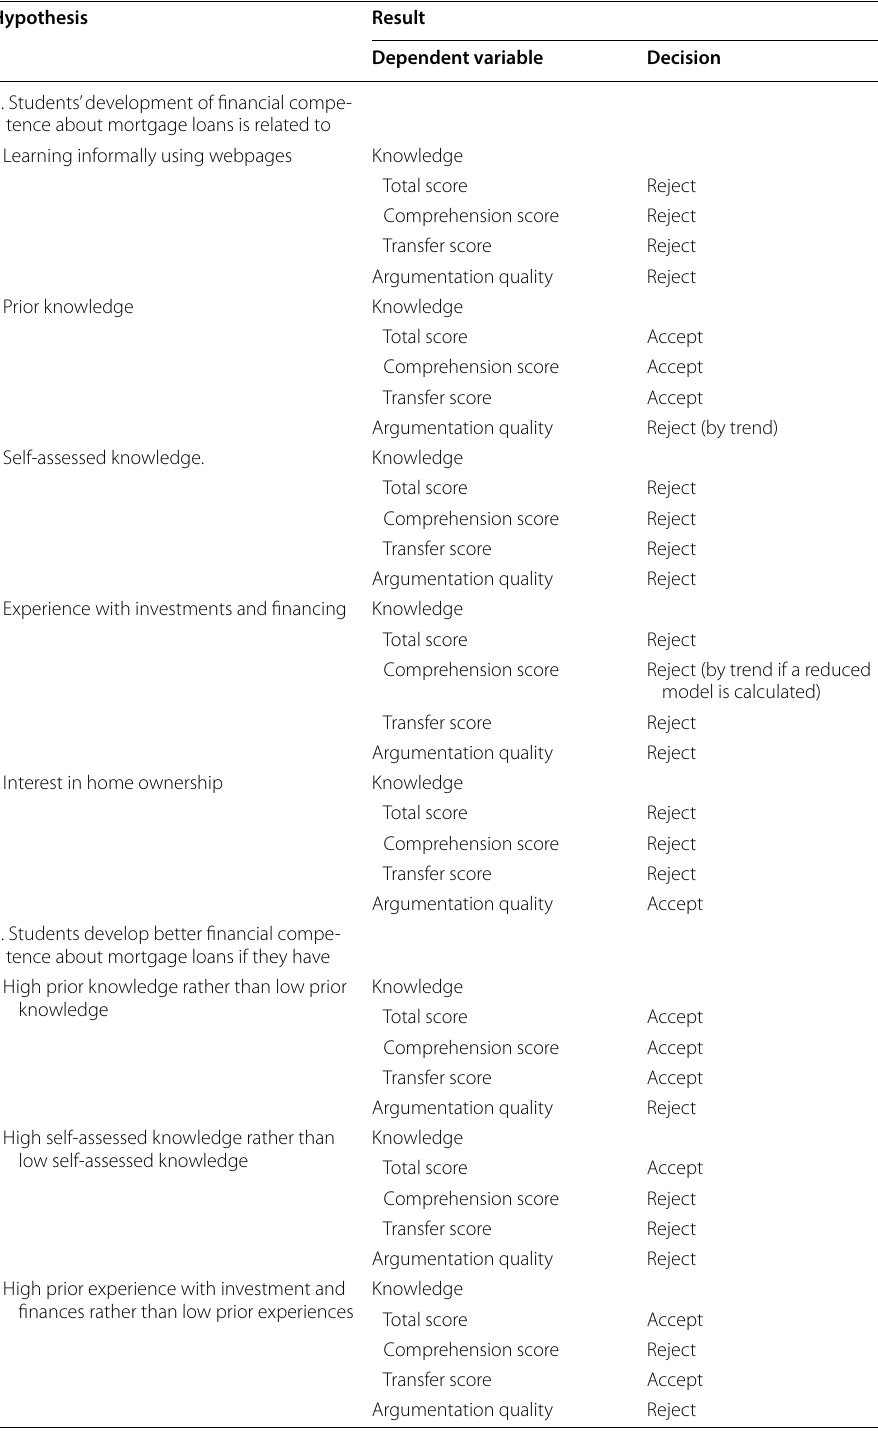
Table 9 Results of hypotheses testing